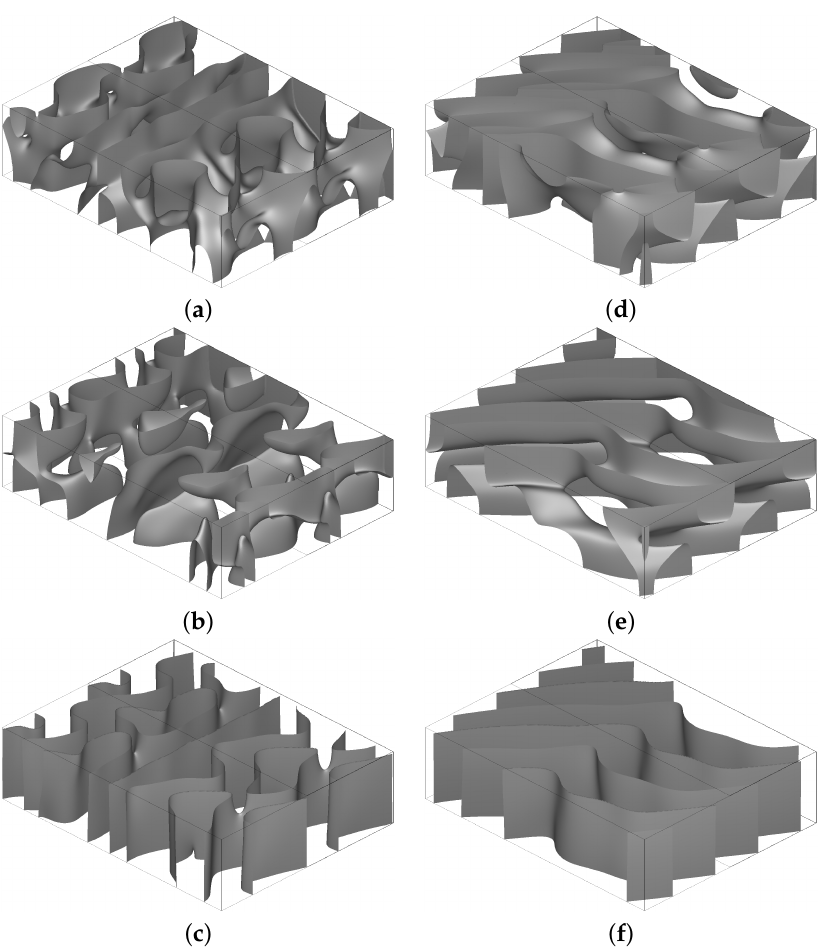
Figure 15. Isosurfaces of the flow components: v 1 = 0 (a), (d); v 2 = 0 (b), (e); v 3 = 0 (c), (f) in run 3 x 1.2 (the standard resolution) at times t = 380.671 (a)–(c) and t = 566.671 (d)–(f). Two adjacent triple-period fluid boxes are shown. However, by the boundary conditions (2.1), v 3 = 0 on the horizontal boundaries, they are not shown as isosurfaces in (c), (f), because that would block the view of the isosurfaces inside the fluid volume.